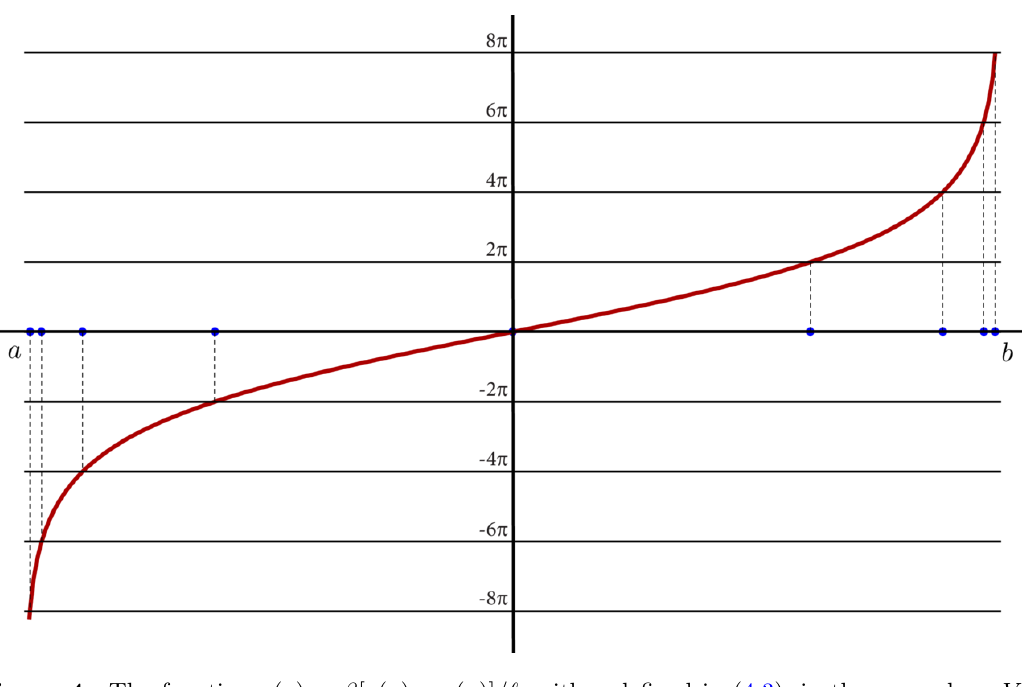
Figure 4. The function g ( y ) = (cid:12) [ z ( y ) (cid:0) z ( x )] =‘ , with z de(cid:12)ned in (4.3), in the case where V is the interval ( a; b ) and x is the midpoint of the interval. Also displayed are the (cid:12)rst few points x n satisfying g ( x n ) = 2 (cid:25)n , which the modular Hamiltonian (4.11){(4.13) couples to x . They tend to accumulate near the endpoints of the